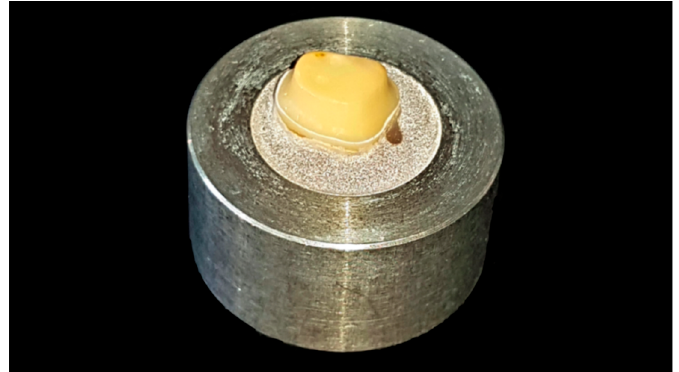
Figure 4. Finalized tooth preparation.